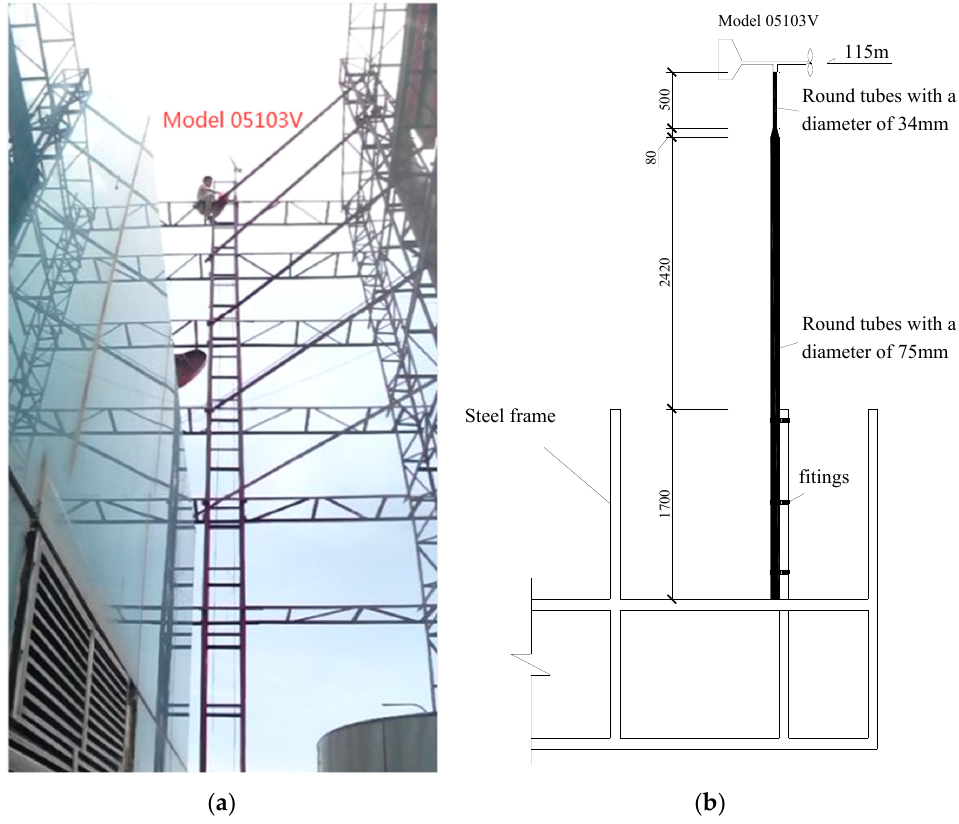
Figure 3. Installation location of Model 05103V anemometer. ( a ) Installation drawing of anemometer; ( b ) Installation detail drawing.